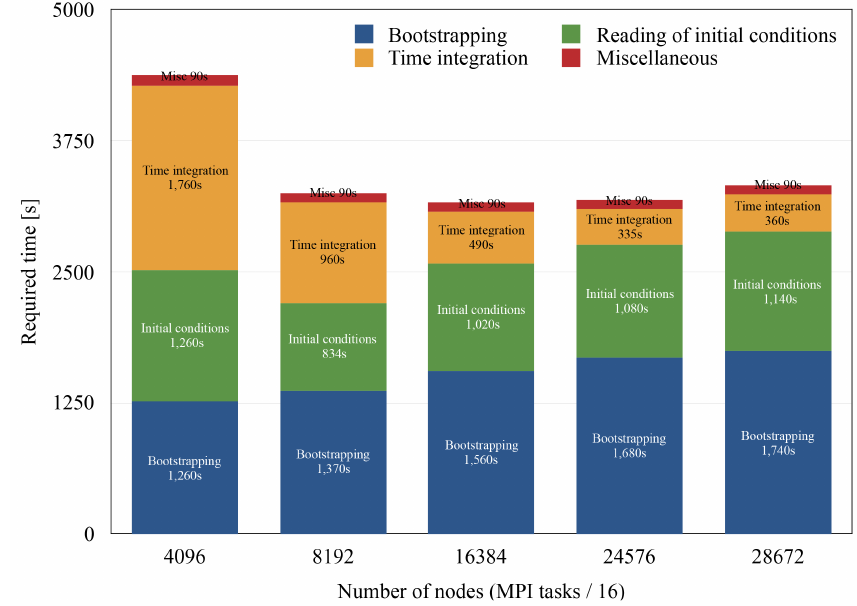
Figure 13. Required times for individual steps of the 3km test runs on Juqueen (18s time